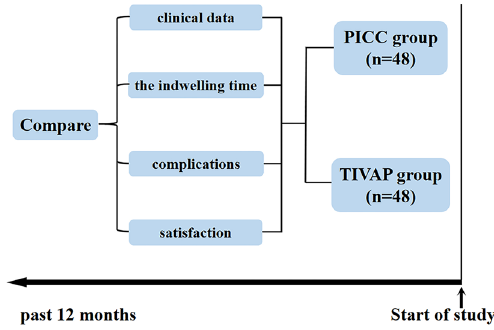
Figure 1. An overview of the study.